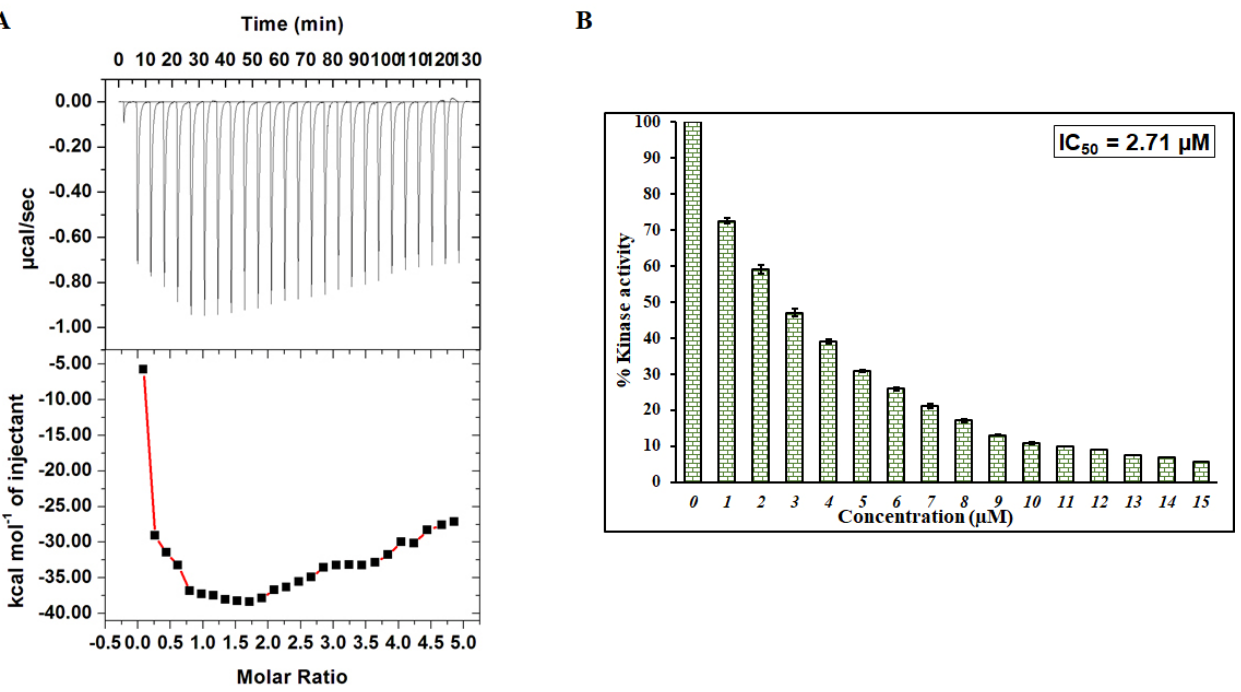
Table 1. Thermodynamic parameters of MARK4–irisin interaction obtained from ITC.